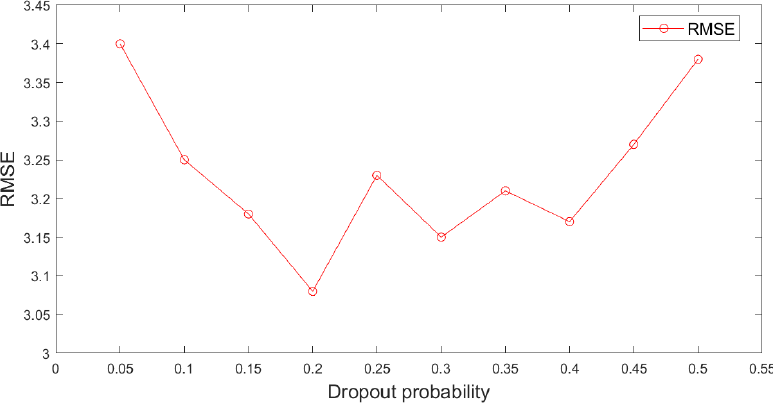
Figure 8. Auxiliary variables used in the intelligent model.